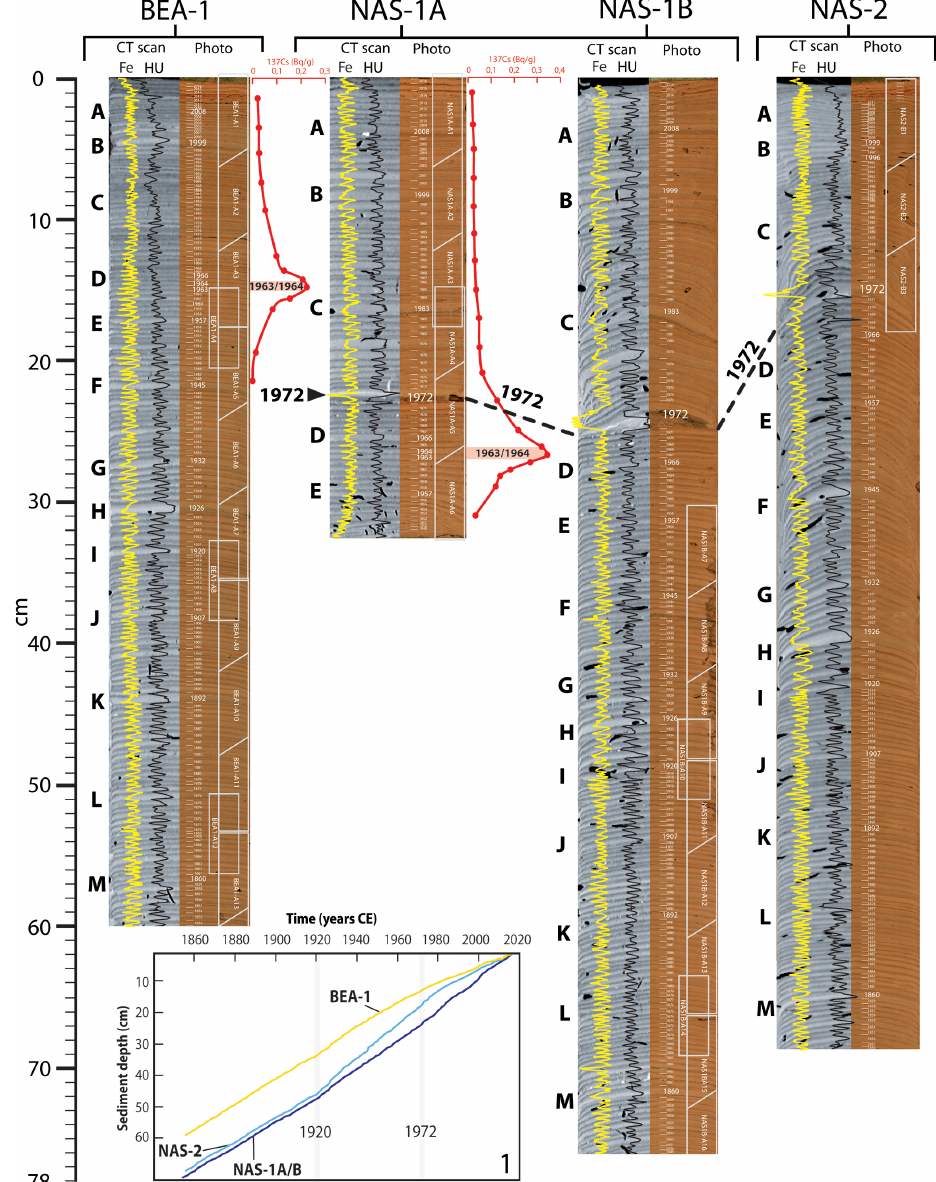
Figure 4. Varve counts made on (left) CT scan and (right) high-resolution images from cores BEA-1, NAS-1A/B and NAS-2. Distinctive marker layers are identified by the letters A to M. The 1972 marker layer is outlined by the thick dark grey line. The Fe relative intensity and density (HU) profiles, represented by the yellow and black lines respectively, show rhythmic laminations. The activity profile of 137 Cs in cores BEA-1 and NAS-1A is shown by the red line. Approximate thin section locations are outlined by white boxes. The age–depth model of the three cores is also presented (Box 1 at the bottom of the figure). See Fig. 1b for core